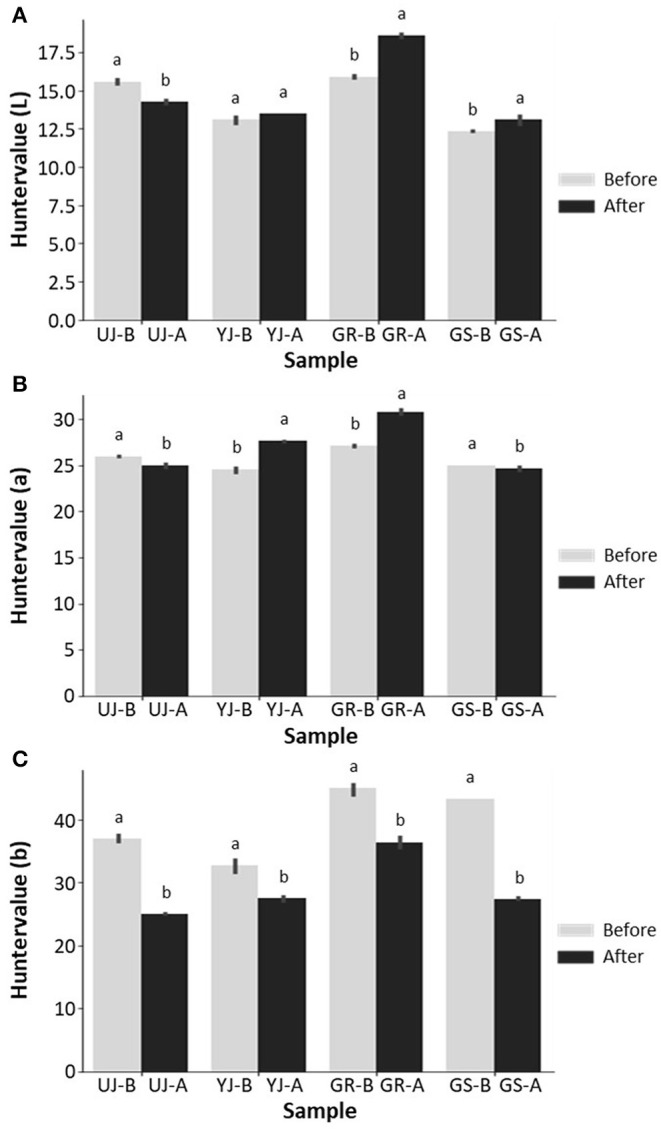
Color parameters of (A) L (lightness), (B) a (redness), and (C) b (yellowness) of gochujang produced in four regions. Data values are indicated as the mean ± standard deviation. Values followed by different letters in the same sample are significantly different (p < 0.05).